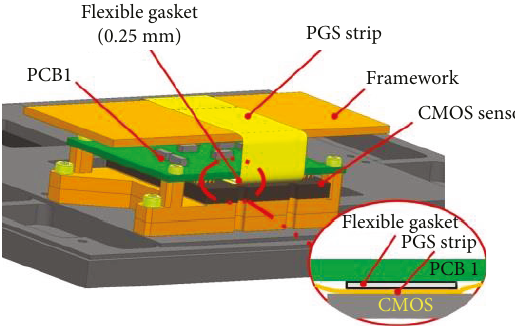
Figure 7: Heat-dissipation